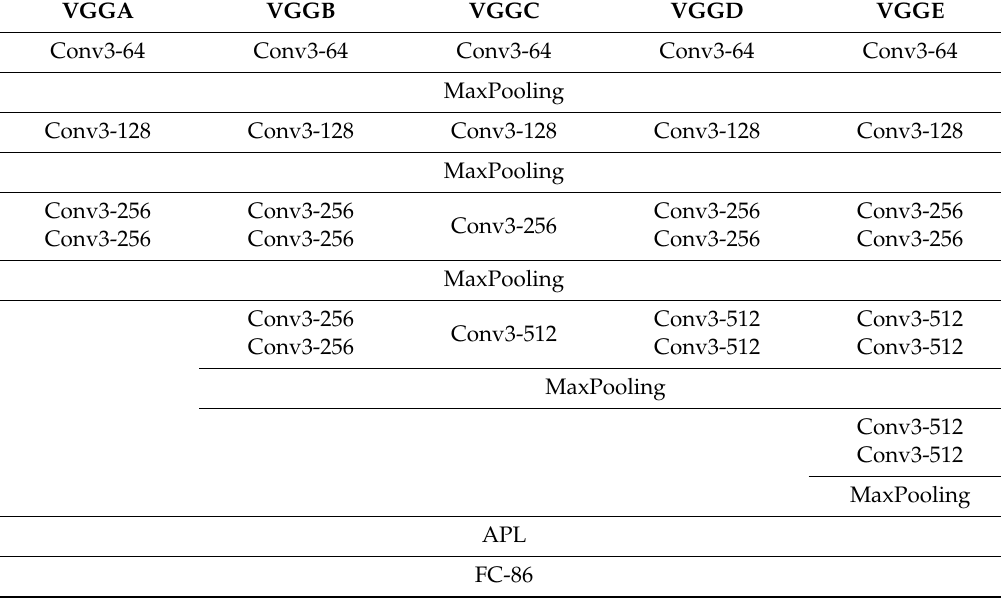
Table 2. Convolutional network layer configuration. Five convolutional network layer structures are defined from VGGA to